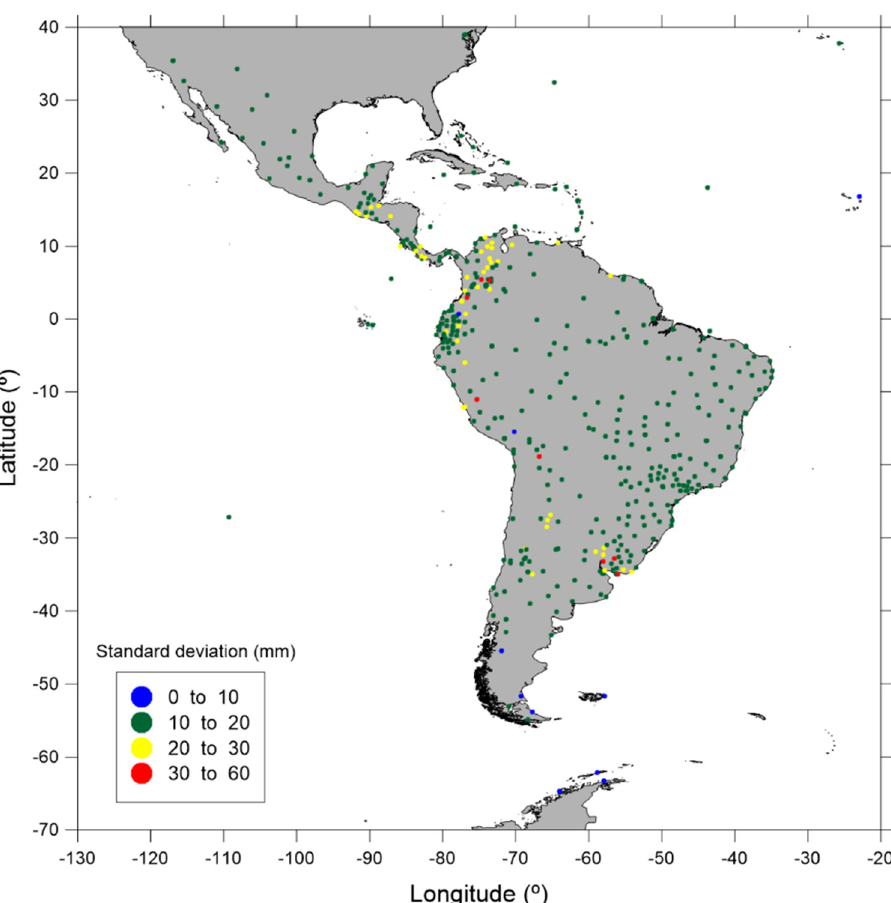
Figure 5: SIRGAS - CON stations with colors representing the standard deviation of the di ff erences between SIRGAS - CON ZTD and ERA5 ZTD for each